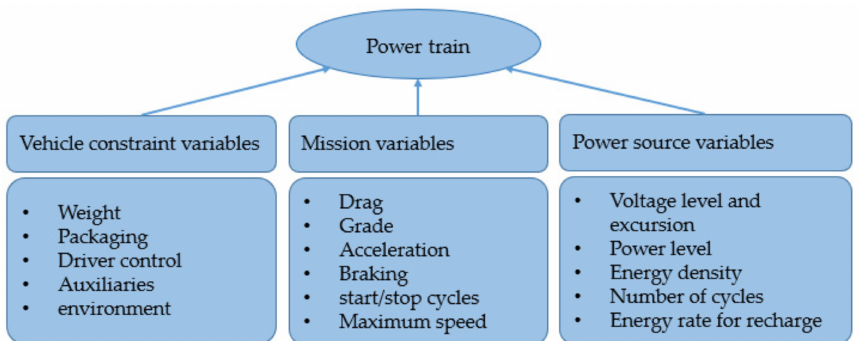
Figure 7. Power train